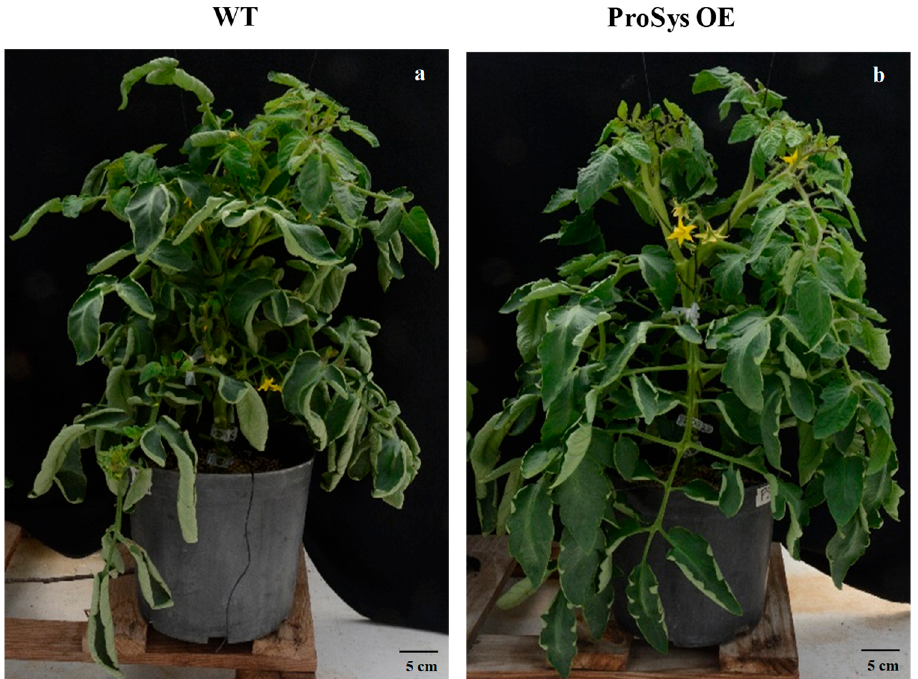
Figure 2. Flowering is accelerated in prosystemin overexpressing tomato plants. Compared to ( a ) wild-type (WT) untransformed tomato plants, ( b ) plants overexpressing the prosystemin (ProSys-OE) precursor protein of the systemin peptide hormone had an accelerated onset of flowering. The images show ProSys-OE and WT plants recorded 30, and 32 days post transplantation into pots,